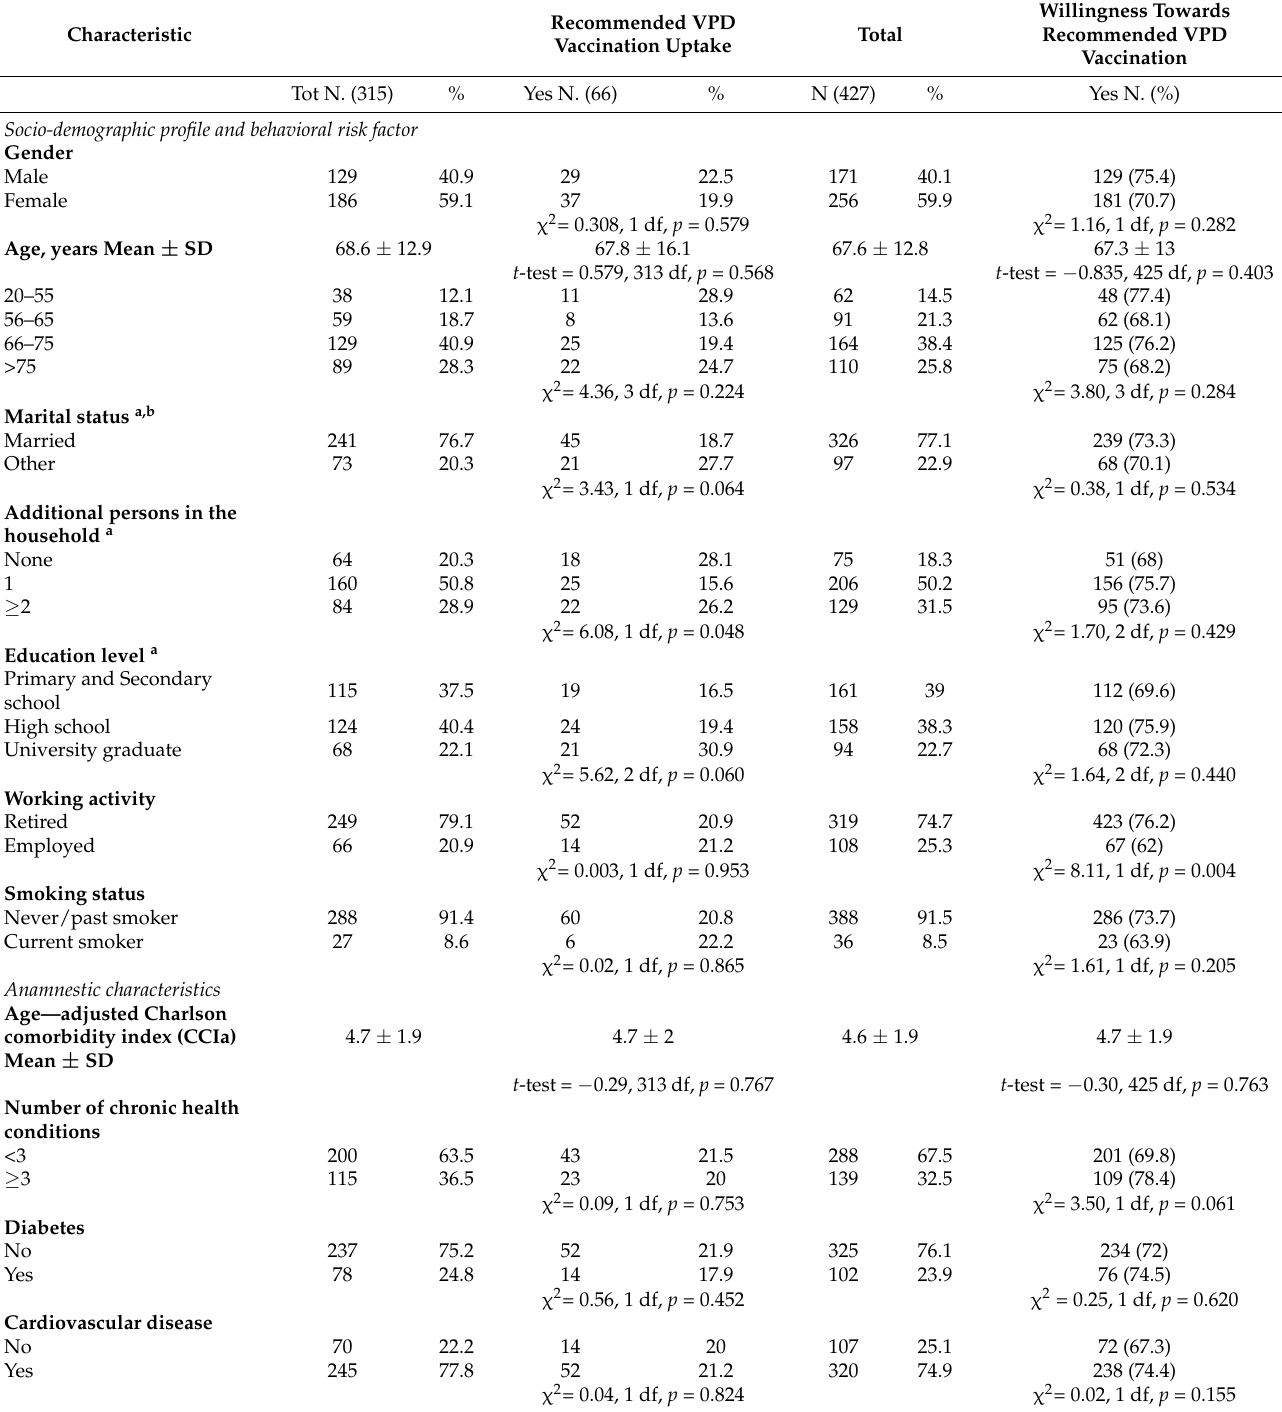
Table 1. Demographic and baseline characteristics of the study population and their association with recommended VPD vaccination uptake and willingness to get